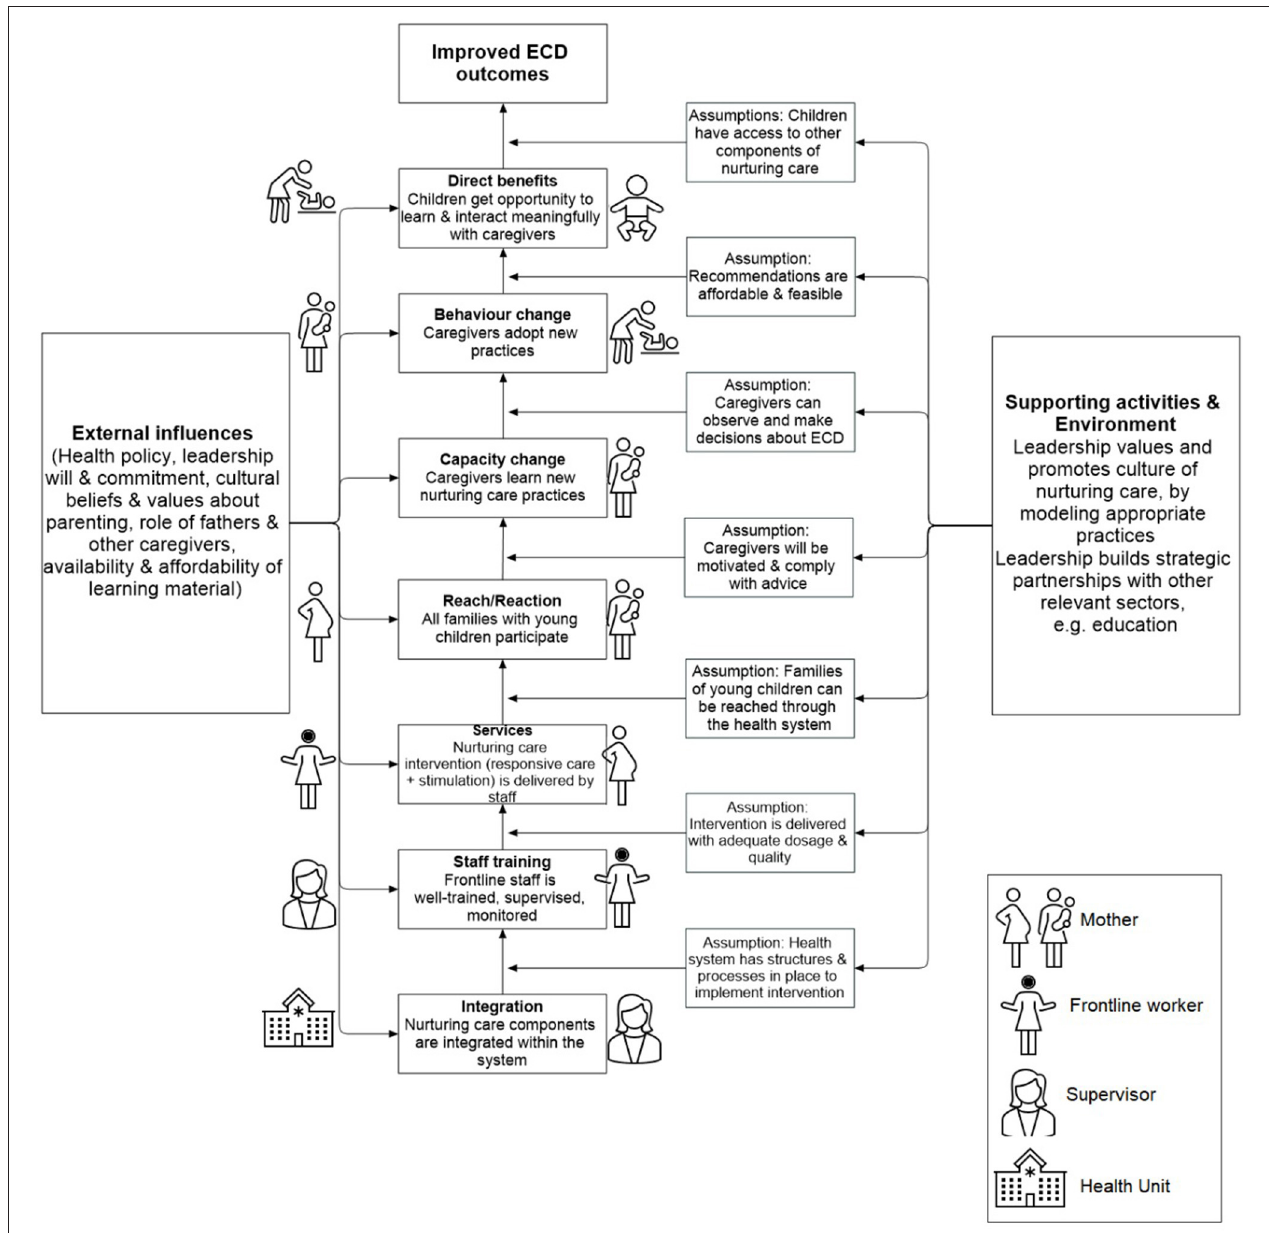
FIGURE 1 | A recommended theory of change for integrating nurturing care intervention in health systems.